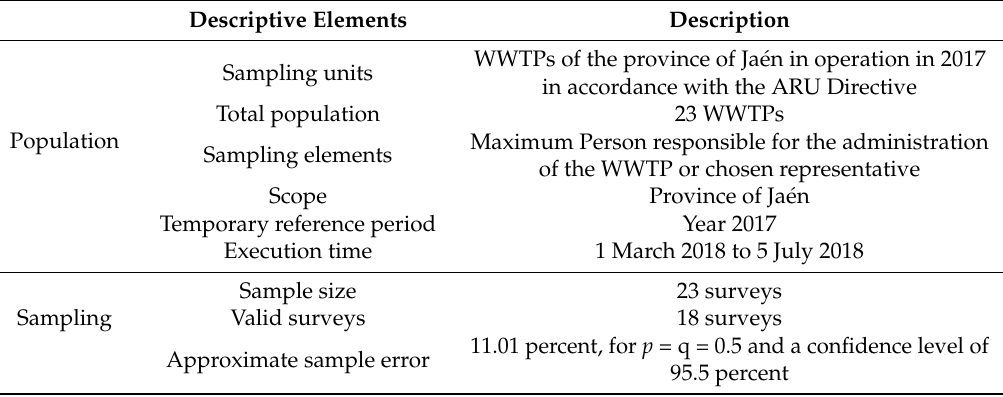
Table 2. Technical data of the empirical study.